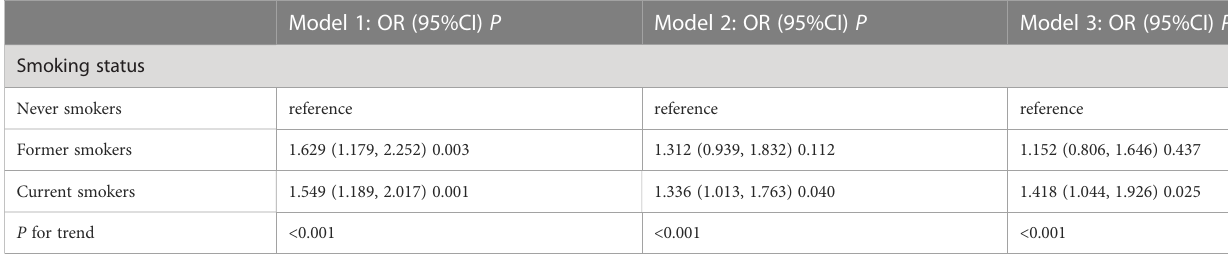
TABLE 2 Association between smoking status and infertility.